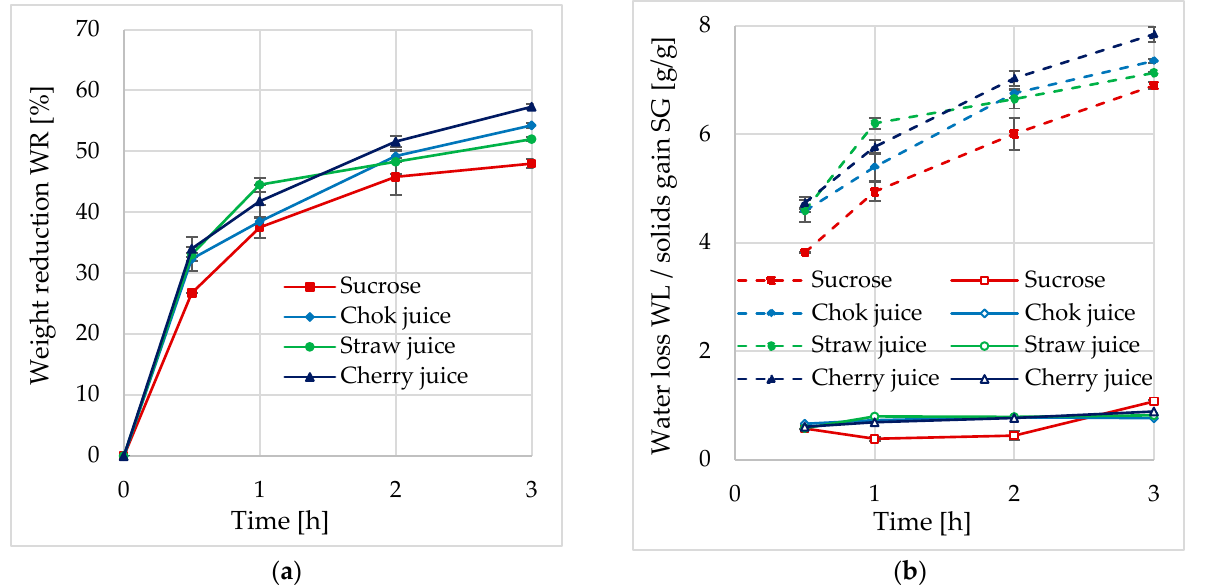
Figure 1. Effect of the type of osmotic agent (fruit concentrates) on the mass exchange kinetics of osmodehydrated strawberries: ( a ) weight reduction, ( b ) water loss (dashed lines), and solid gain (regular lines).